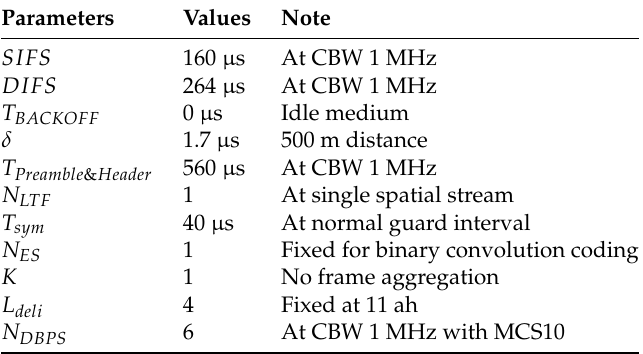
Table 5. Parameter assumption of IEEE 802.11ah message transfer delay